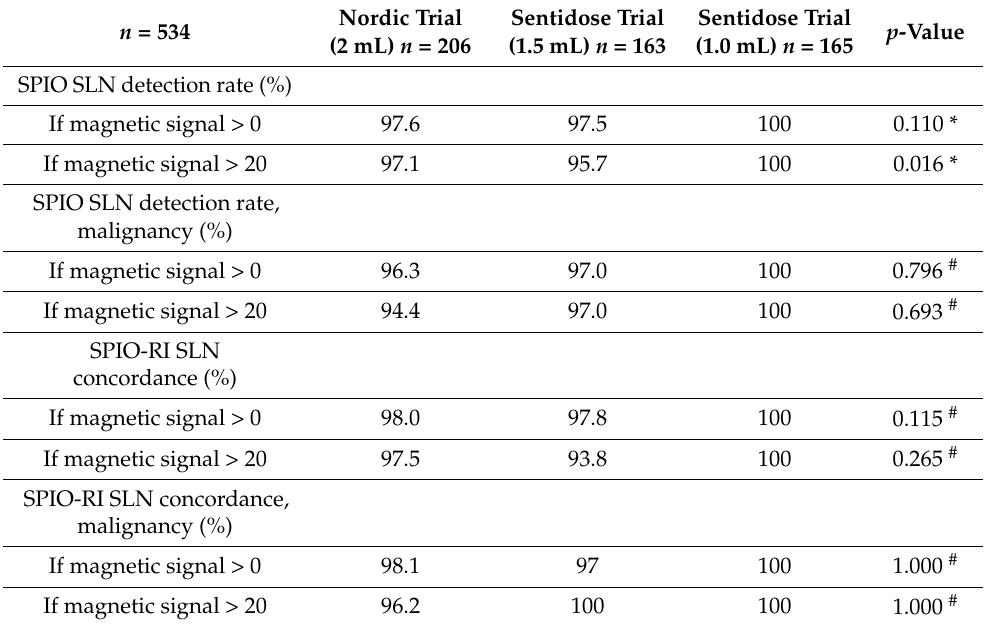
Table 2. Sentinel lymph node identification—per patient.